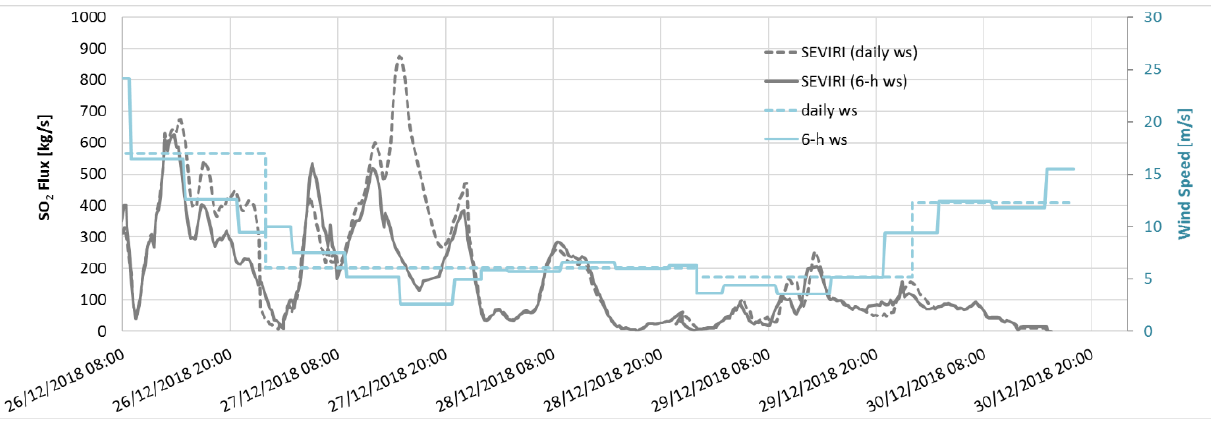
Figure 11. SO 2 flux obtained from SEVIRI 15-minute measurements, considering a fixed transect at 30 km from the vents. The gray dashed line indicates the flux obtained considering daily constant wind speed, while the gray solid line indicates the flux obtained considering the 6 h step wind speeds. The dashed and solid light blue lines indicate, respectively, the daily and 6 h wind speeds used for the SO 2 flux computations.